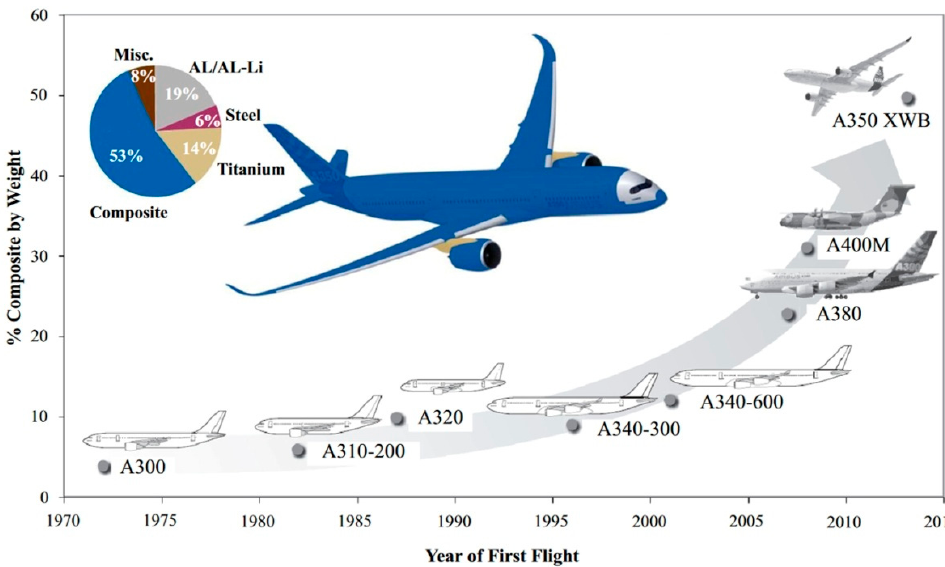
Figure 1. Trends in the use of composite materials in Airbus aircraft (reprinted with permission from [32]; copyright© 2021, Springer International Publishing AG, part of Springer Nature).